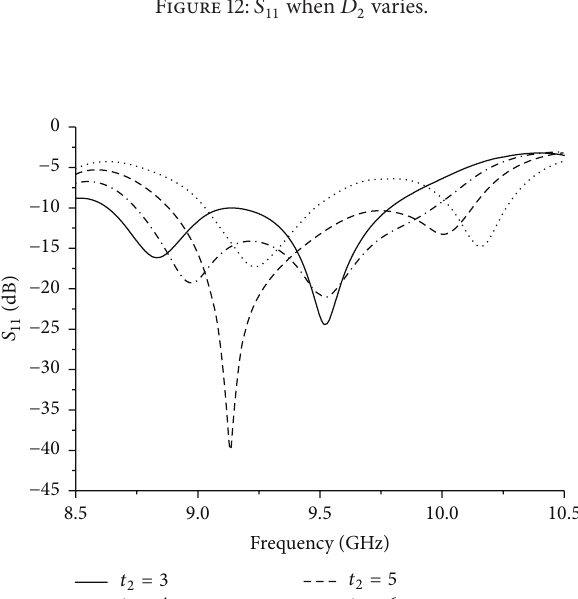
Figure 14: 𝑆 11 when 𝑤 2 varies.